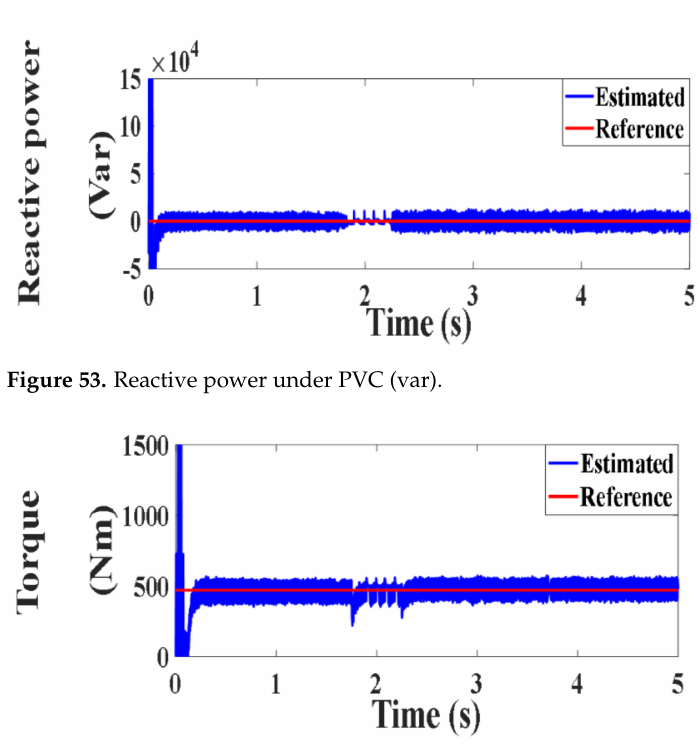
Figure 52. Active power under PVC (Watt).